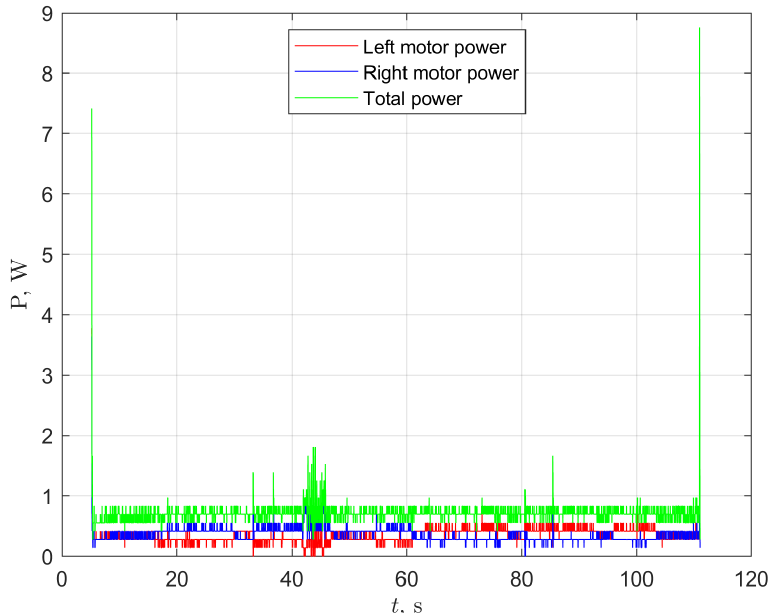
Figure 13. Individual motor power and the total power over time, for the mid value of the cost function equal to 1.0930—track 1.